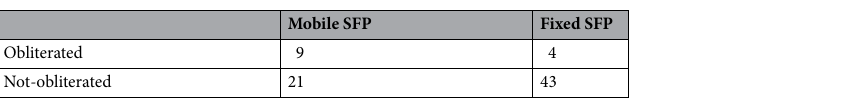
Table 1. Distribution of the condition of the middle ear and stapes footplate (SFP) of the 77 ears (74 patients) that contributed data to the